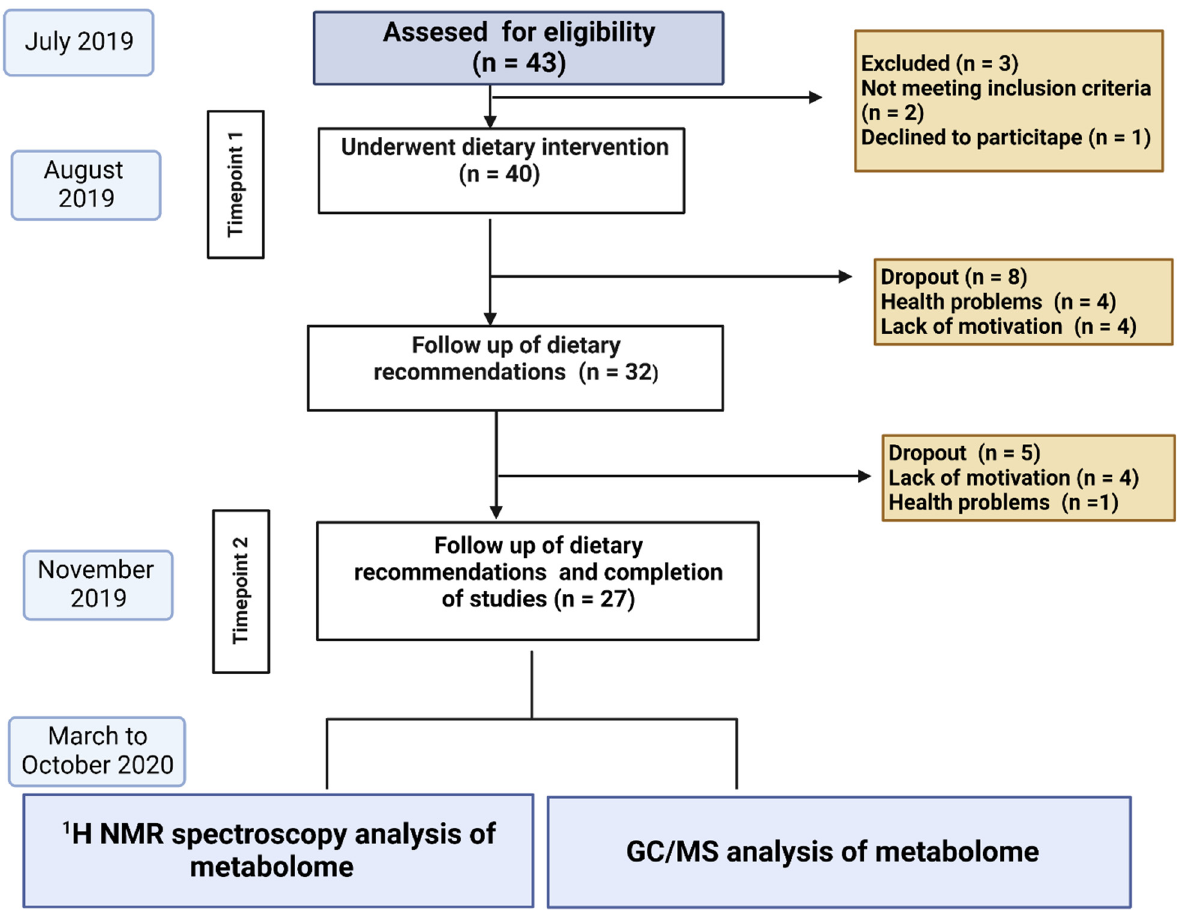
Figure 1. Description of the tests performed. GC/MS chromatography (GC/MS), Nuclear magnetic resonance spectroscopy 1 H NMR. resonance spectroscopy 1 H